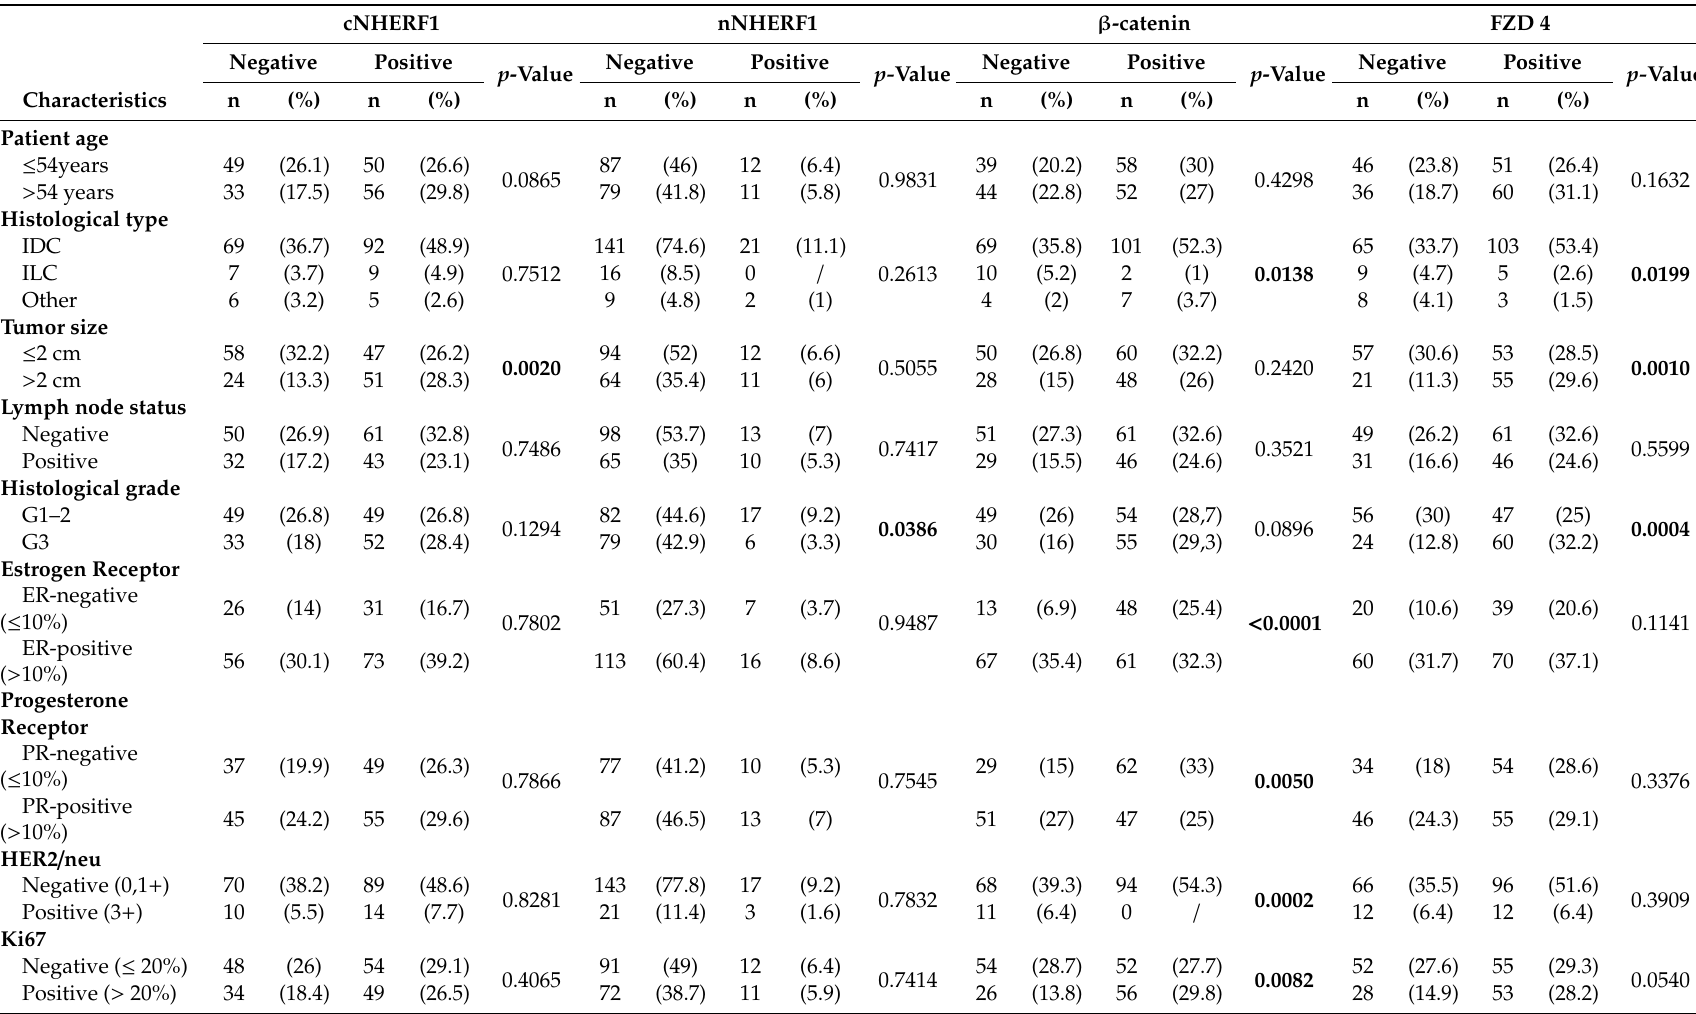
Table 1. Relationship between tumor markers and clinicopathological